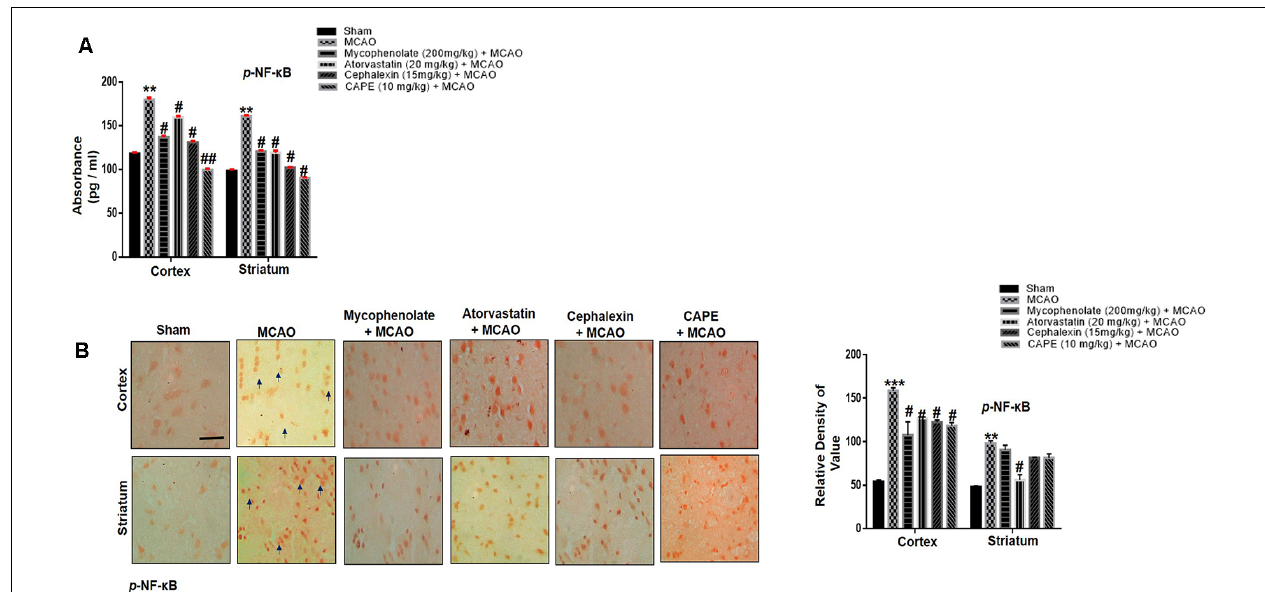
FIGURE 5 | Effect of test drugs on p -NF- κ B. Panel (A) illustrates the effect of atorvastatin, cephalexin, mycophenolate, and CAPE on p -NF- κ B expression in cortex and striatum by Elisa. Two-way analysis of variance (ANOVA) was used to analyze the results. The expression level of p -NF- κ B was significantly decreased in the treatment vs. MCAO group. ** indicates p < 0.01, while ## represent p < 0.01 significant difference, and # indicates p < 0.05. Symbols * shows significant difference relative to sham control while # shows significant difference relative to MCAO. (B) Effect of atorvastatin, cephalexin, mycophenolate, and CAPE on immunohistochemistry of p -NF- κ B in cortex and striatum. Two-way ANOVA was used to analyze the data, scale bar 20 µ m, magnification 40X and ( n = 6/group). p -NF- κ B exhibits nuclear localization, *** indicates p < 0.001, while symbol ** represent p < 0.01, and # indicates p < 0.05 significant difference. The symbol * shows significant difference relative to sham control while # shows significant difference relative to